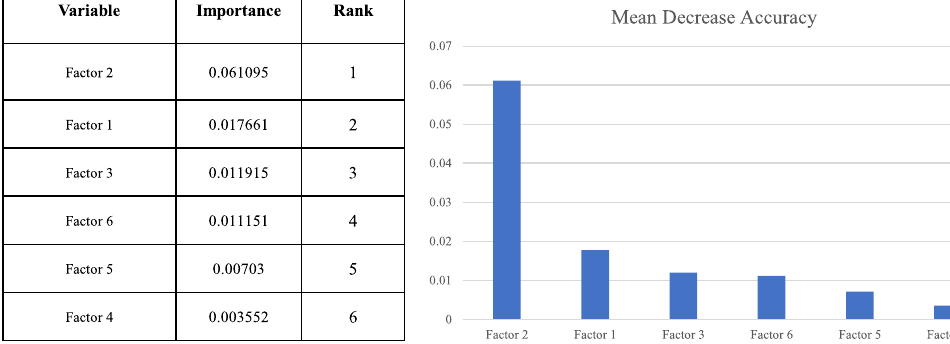
Figure 1. Importance of principal component analysis factors estimated using random survival forest analysis. Variables with the highest importance values were found to be the best predictors of primary clinical